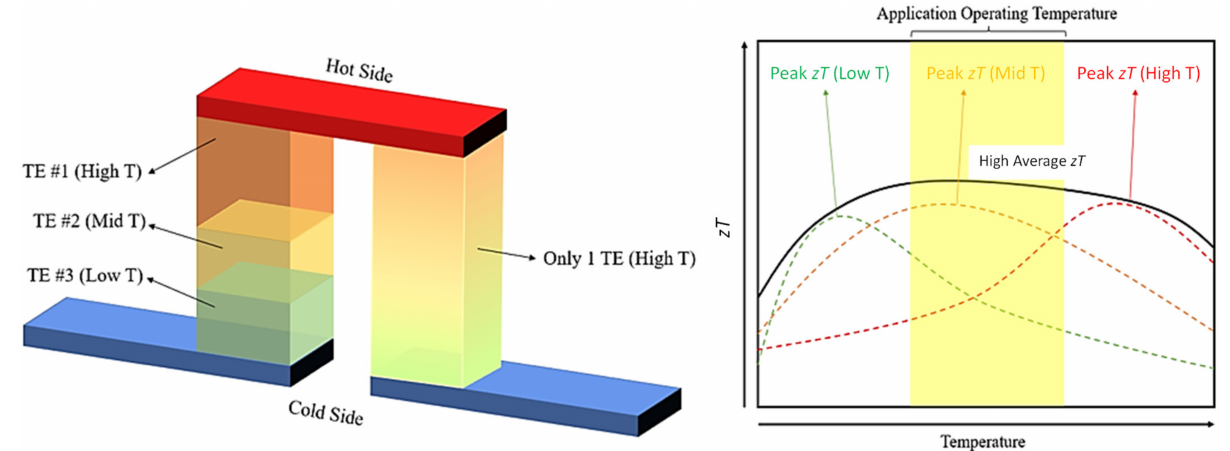
Figure 8. Segmented thermoelectric legs improve the average zT across a wider temperature range in comparison with single material